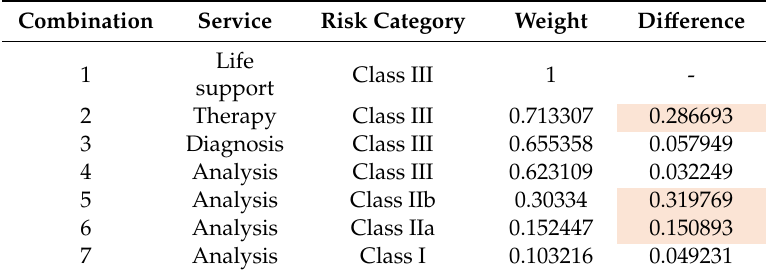
Table 17. Top–down technique for the criterion Function.